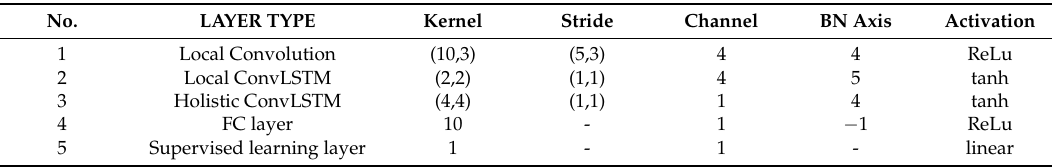
Table 4. Parameters of the proposed model used in tool wear monitoring experiments No.